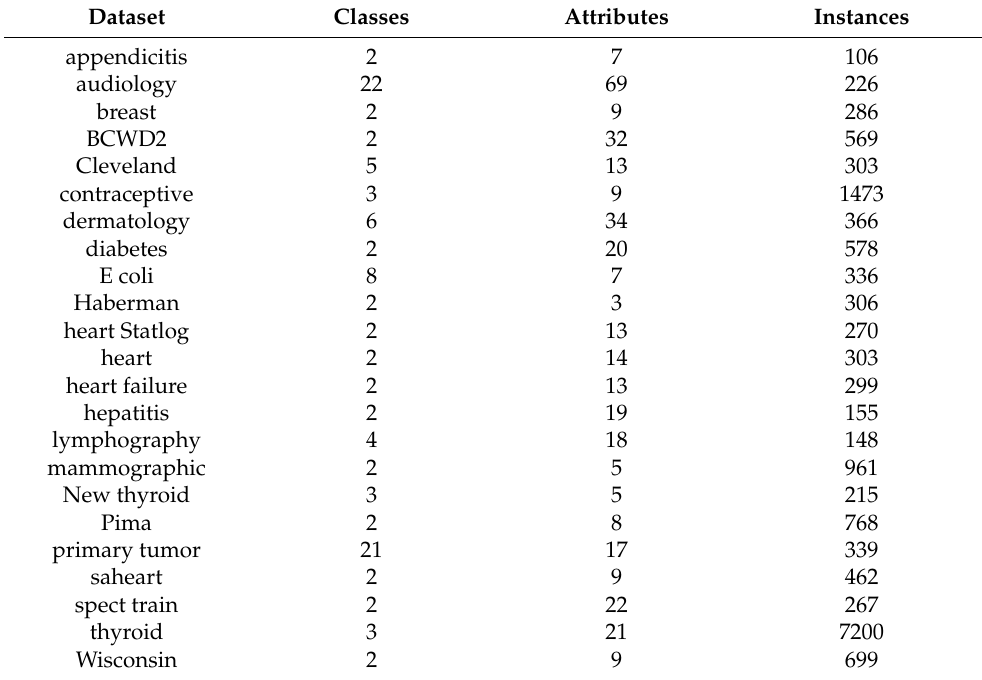
Table 1. Description of the